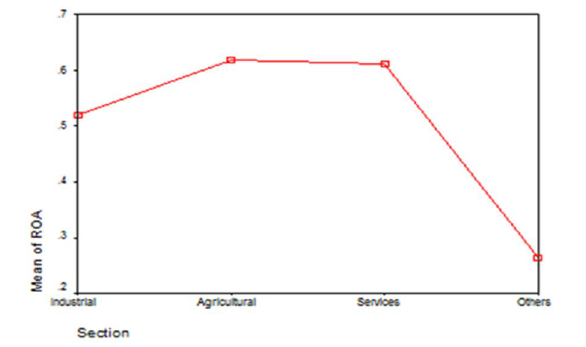
Figure 3- comparing the ROA of different sectors at high investment